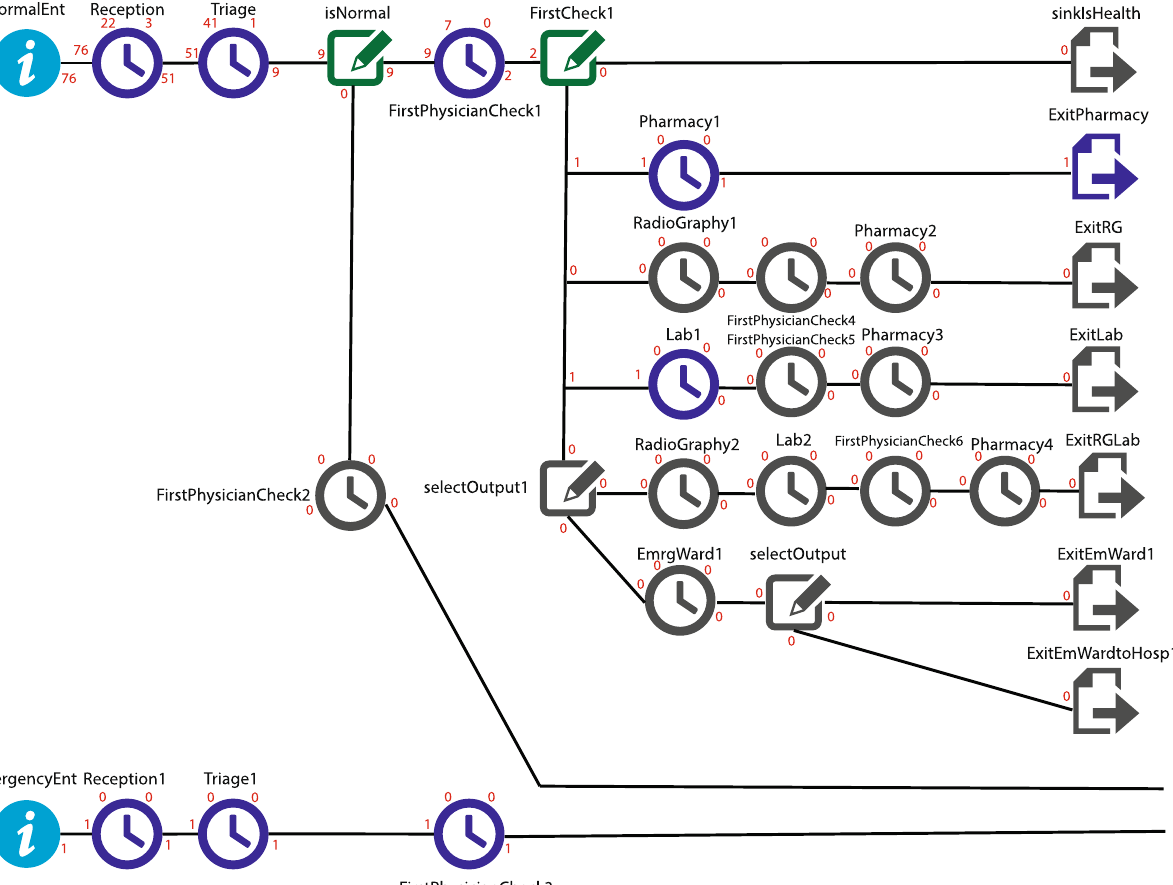
Figure 2. Simulation model of appointment scheduling for two different patient